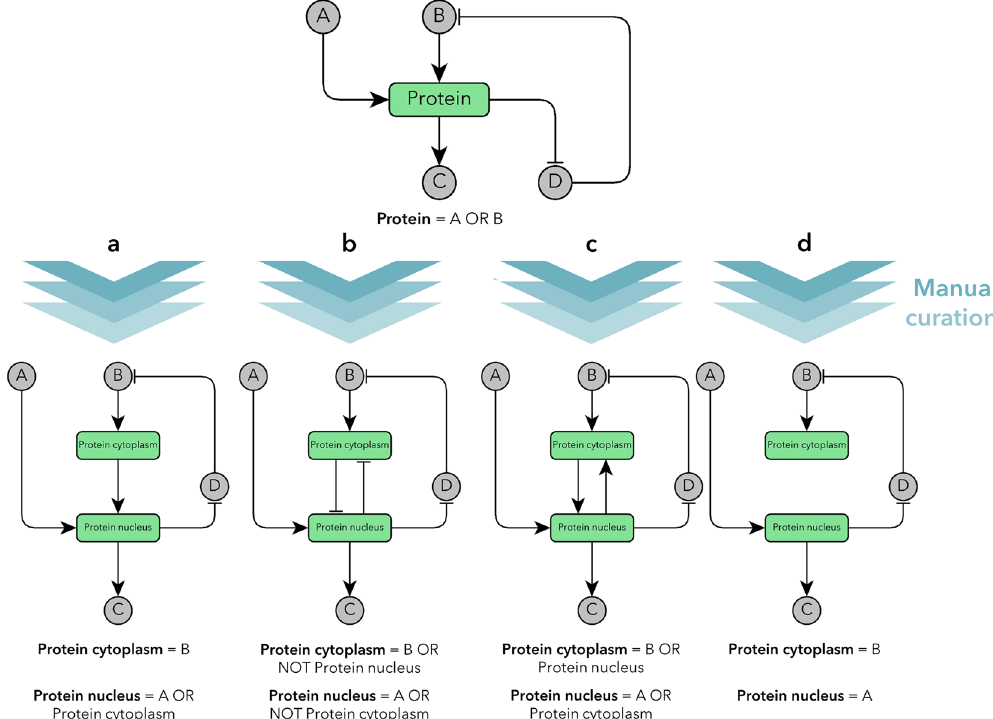
Fig. 2 Creation of compartmentalized Boolean rules. Conventionally in the network representation of signalling processes nodes are individual proteins and edges (either inhibitory or activatory) are interactions between them, but their localization speci fi city is not considered. We take into consideration the compartment-speci fi c functions of proteins so we can systematically add this information to Boolean models. After the careful revision of available literature data (manual curation) we created a compartmentalized Boolean network. In this hypothetical explanatory example we highlighted a “ translocating protein ” with green. a One possibility is that after e.g., phosphorylation by B the protein translocates to the nucleus and this does not directly affect the cytoplasmic pool of that protein. b Another possibility was already contained in the original EMT model (in the case of CTNNB), where the nodes mutually inhibit each other. c Some transcription factors can upregulate their own expression which can act as a positive feedback, d but it is also possible that both the cytoplasmic and the nuclear pools of a protein have their own regulatory interactions but they don ’ t affect each other directly. There are also other potential combinatorial possibilities (see Supplementary Fig. 7). During compartmentalization we always followed the logic of the available experimental data and tried to interpret into Boolean rules. As the nodes represent the functionality not the mass of proteins the simultaneous activation of both nodes does not negate the law of mass conservation (more on this topic in Supplementary Note